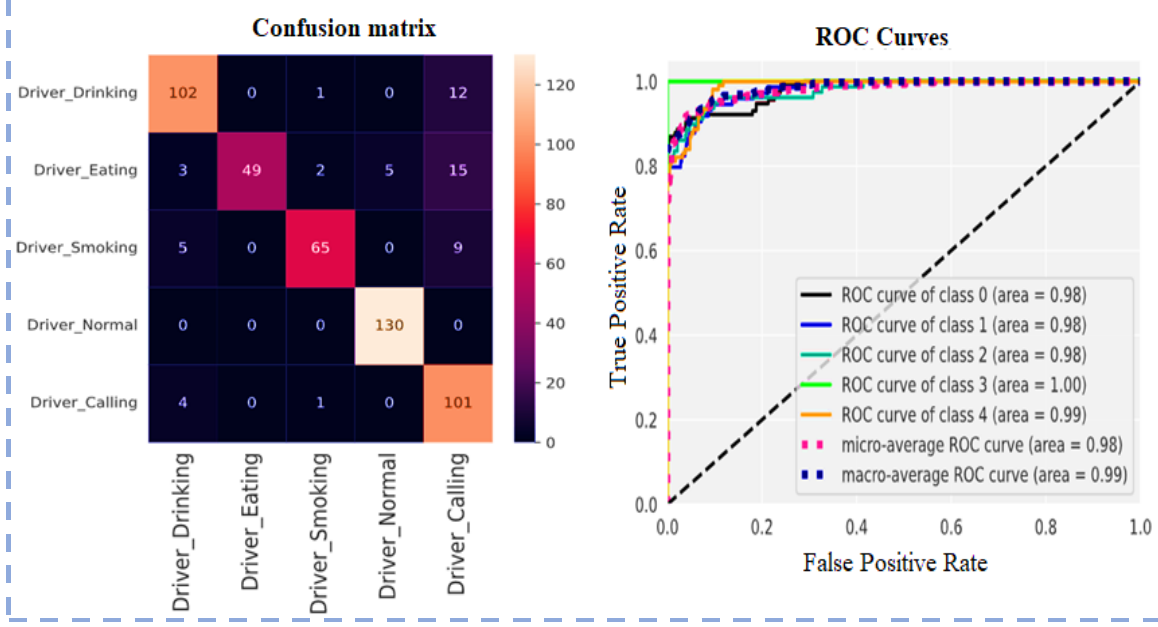
Figure 7. Confusion matrix and ROC Curves using ResNet101.